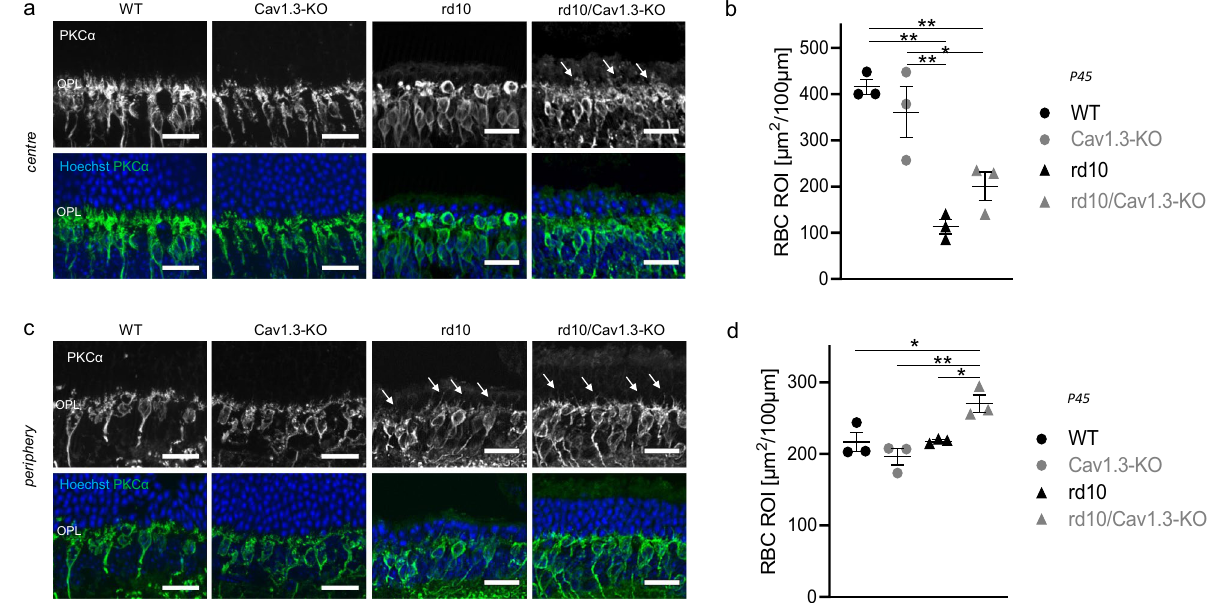
Figure 5. Rod bipolar cell dendritic arbours. Co-immunostaining with PKCα (green) and Hoechst (blue) nuclear staining (blue) shows rod bipolar cell dendritic arbours and the cell nuclei respectively in the central (a) and peripheral (c) regions of wild type, Cav1.3-KO, rd10 and rd10/Cav1.3-KO retinas at P45. Rod bipolar cells lack dendritic trees in the central region of rd10 retinas. Few dendritic sprouts into the ONL (arrows) were identified in the central region of rd10/Cav1.3-KO retinas and in the periphery of both rd10 strains. (b) and (d) shows the quantification of dendritic arborizations in central (b) and peripheral (d) retinas [in µm 2 ]: centre: wild type (WT): 416 ± 16; Cav1.3-KO: 361 ± 56; rd10: 112.9 ± 15.7; rd10/Cav1.3-KO: 201 ± 30.7; periphery: wild type: 216.7 ± 13.6; Cav1.3-KO: 195.7 ± 11.3; rd10: 217.8 ± 2; rd10/Cav1.3-KO: 270.2 ± 12.1. N = 3 for all strains. Statistics: *** p < 0.001 in centre; ** p = 0.007 in periphery, One-way ANOVA with Holm-Sidak’s multiple comparison test. Data are presented as means ± SEM. Scale bars: 20 Rod bipolar cell dendrites in rd10/Cav1.3‑KO mice. Dendritic regression of rod bipolar cells (RBCs)